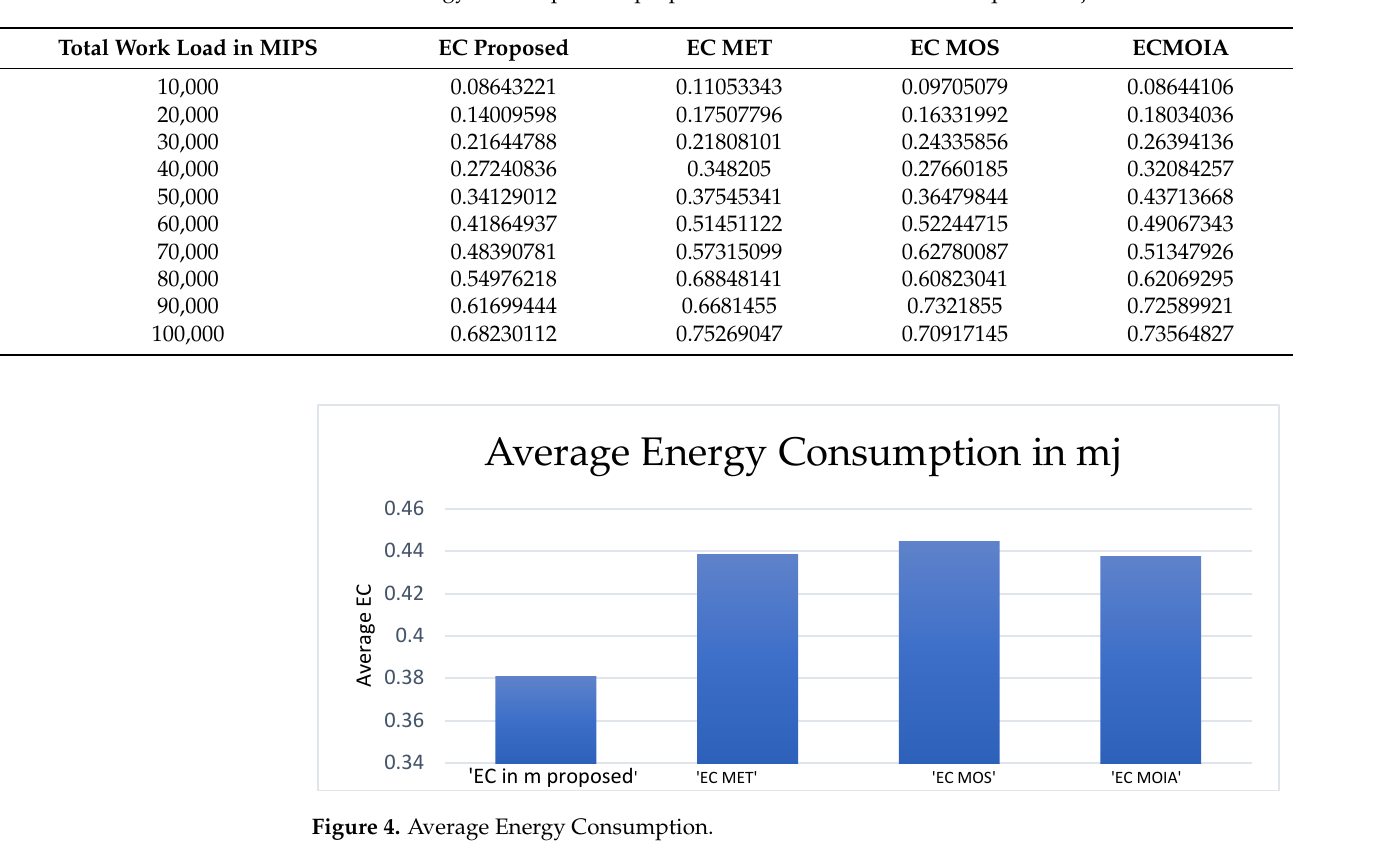
Table 3. Energy consumption of proposed and state of the art techniques in mj.